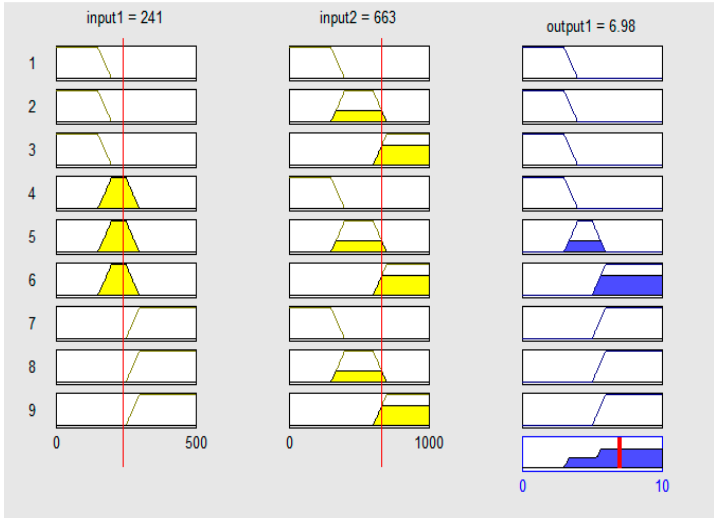
Figure 9. An example of fuzzy-rules-based decision.